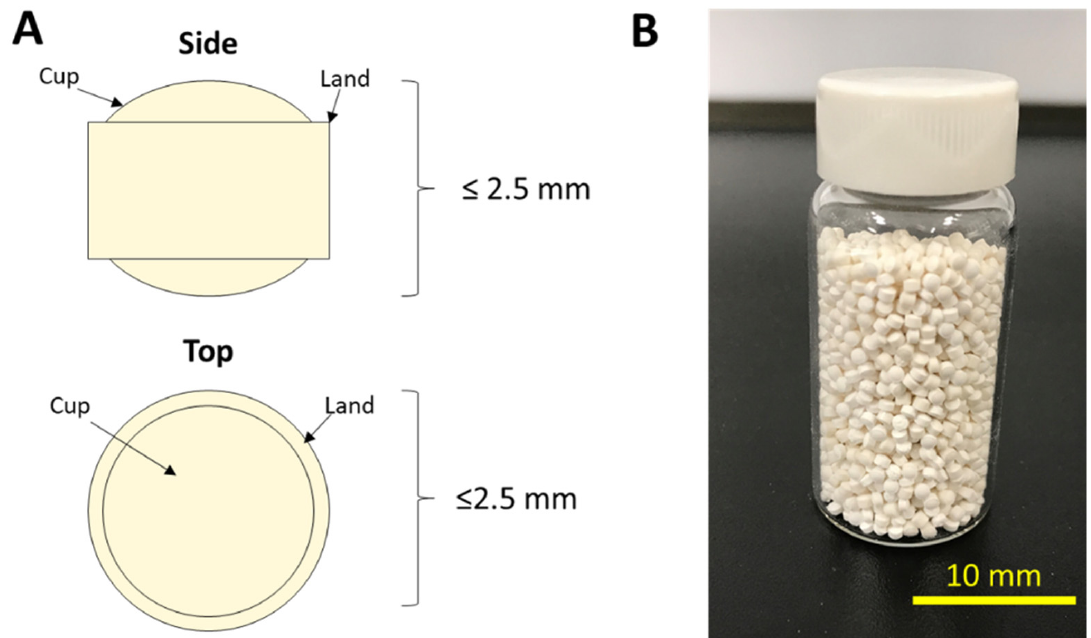
Figure 1. Oral granules comprise a compressed oral solid dosage form 1.0–2.5 mm in diameter and offer a quasi-flexible dosing solution for pediatric populations by varying fill count per dosage unit. ( A ) schematic illustration of mini-tablet features and ( B ) image of a vial filled with mini-tablets 2 mm in diameter (therefore qualifying as oral granules and treated as such for content uniformity evaluation).